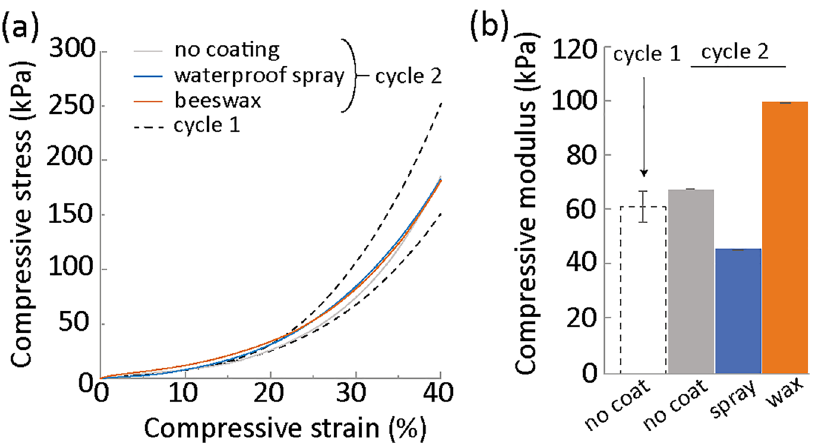
Figure 6. Compression tests of MBCs made from 50% substrate recovered from a used, compressed composite that had no coating (grey), the waterproof spray coating (blue) and the beeswax coating (orange) and compared to the fresh MBCs (dotted line). ( a ) Stress–strain curves obtained under compression after 28 days mycelium growth. ( b ) Elastic